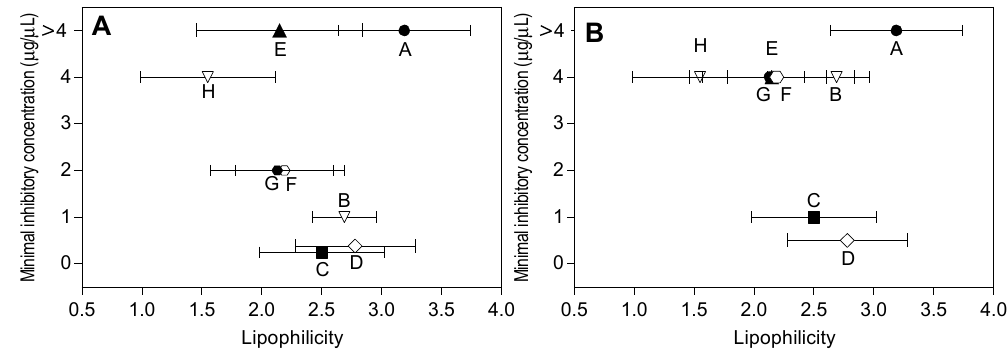
Figure 5. Minimal inhibitory concentration and lipophilicity relationship between flavonoids. ( A ) B. subtilis ; and ( B ) E. coli . The compounds used were: A (3,7- O -dimethylgalangin), B (pinocembrin), C (galangin), D (3- O -methylgalangin), E (3- O -methylisorhamnetin), F (naringenin), G (7- O -methyleriodictyol), and H (quercetin), which are indicated by small uppercase letters.